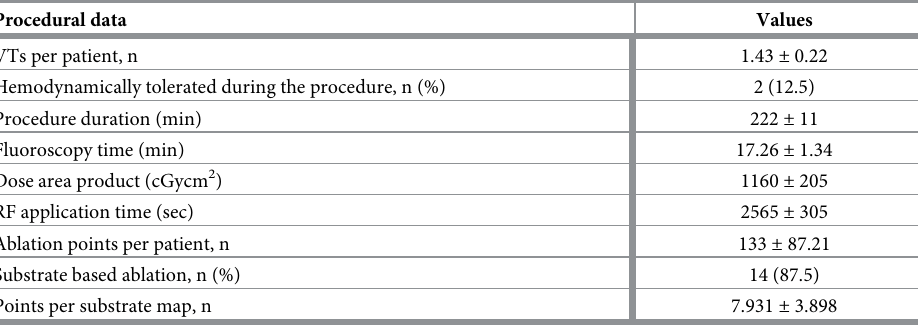
Table 2. Procedural